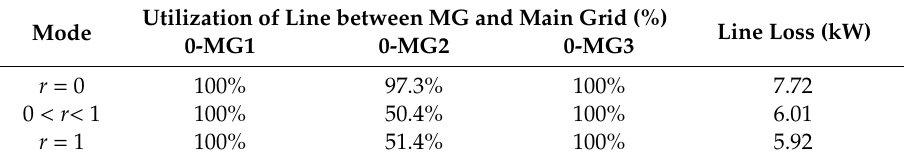
Table 8. Utilization of line and line